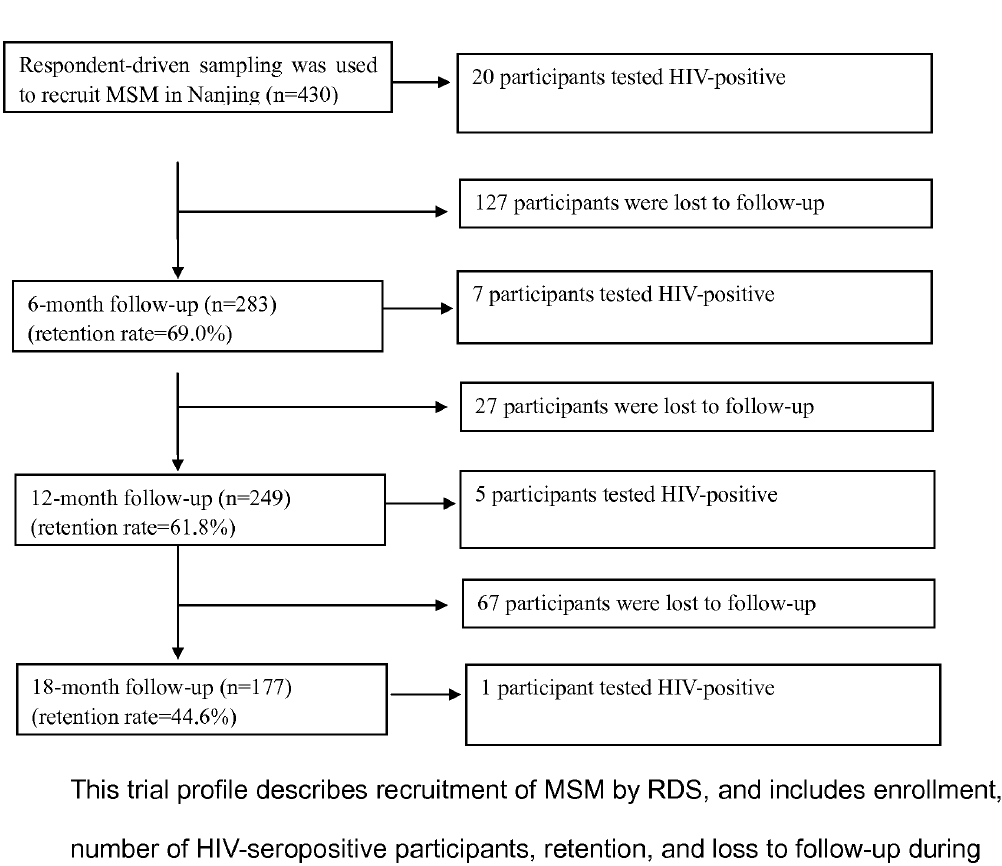
Figure 2. Enrollment, follow-up, and outcome of the participants. This trial profile describes recruitment of MSM by RDS, and includes enrollment, number of HIV-seropositive participants, retention, and loss to follow-up during each follow-up.